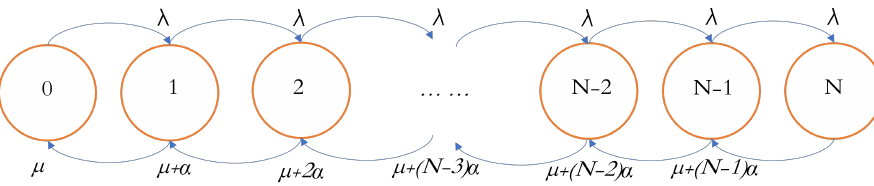
Figure 1. Rate diagram for a single-server queuing model with impatient